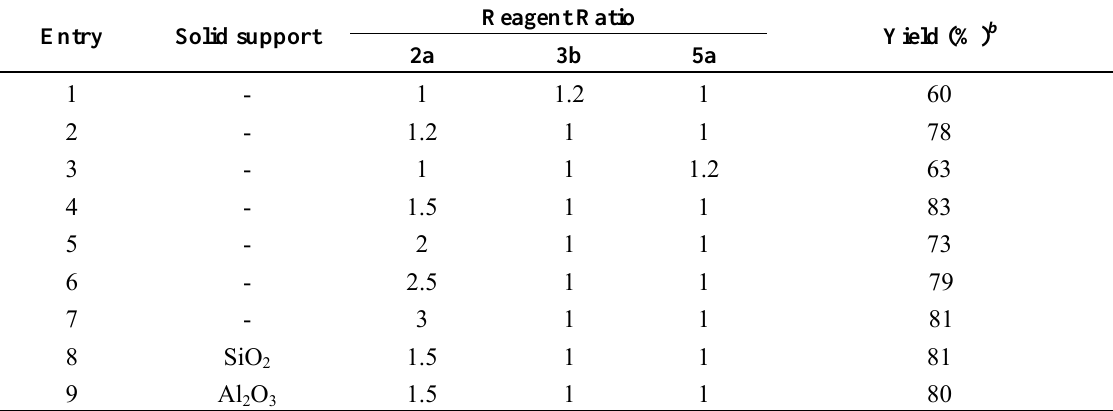
Table 2. Optimization of the reactant’s equivalence ratio and solid support.